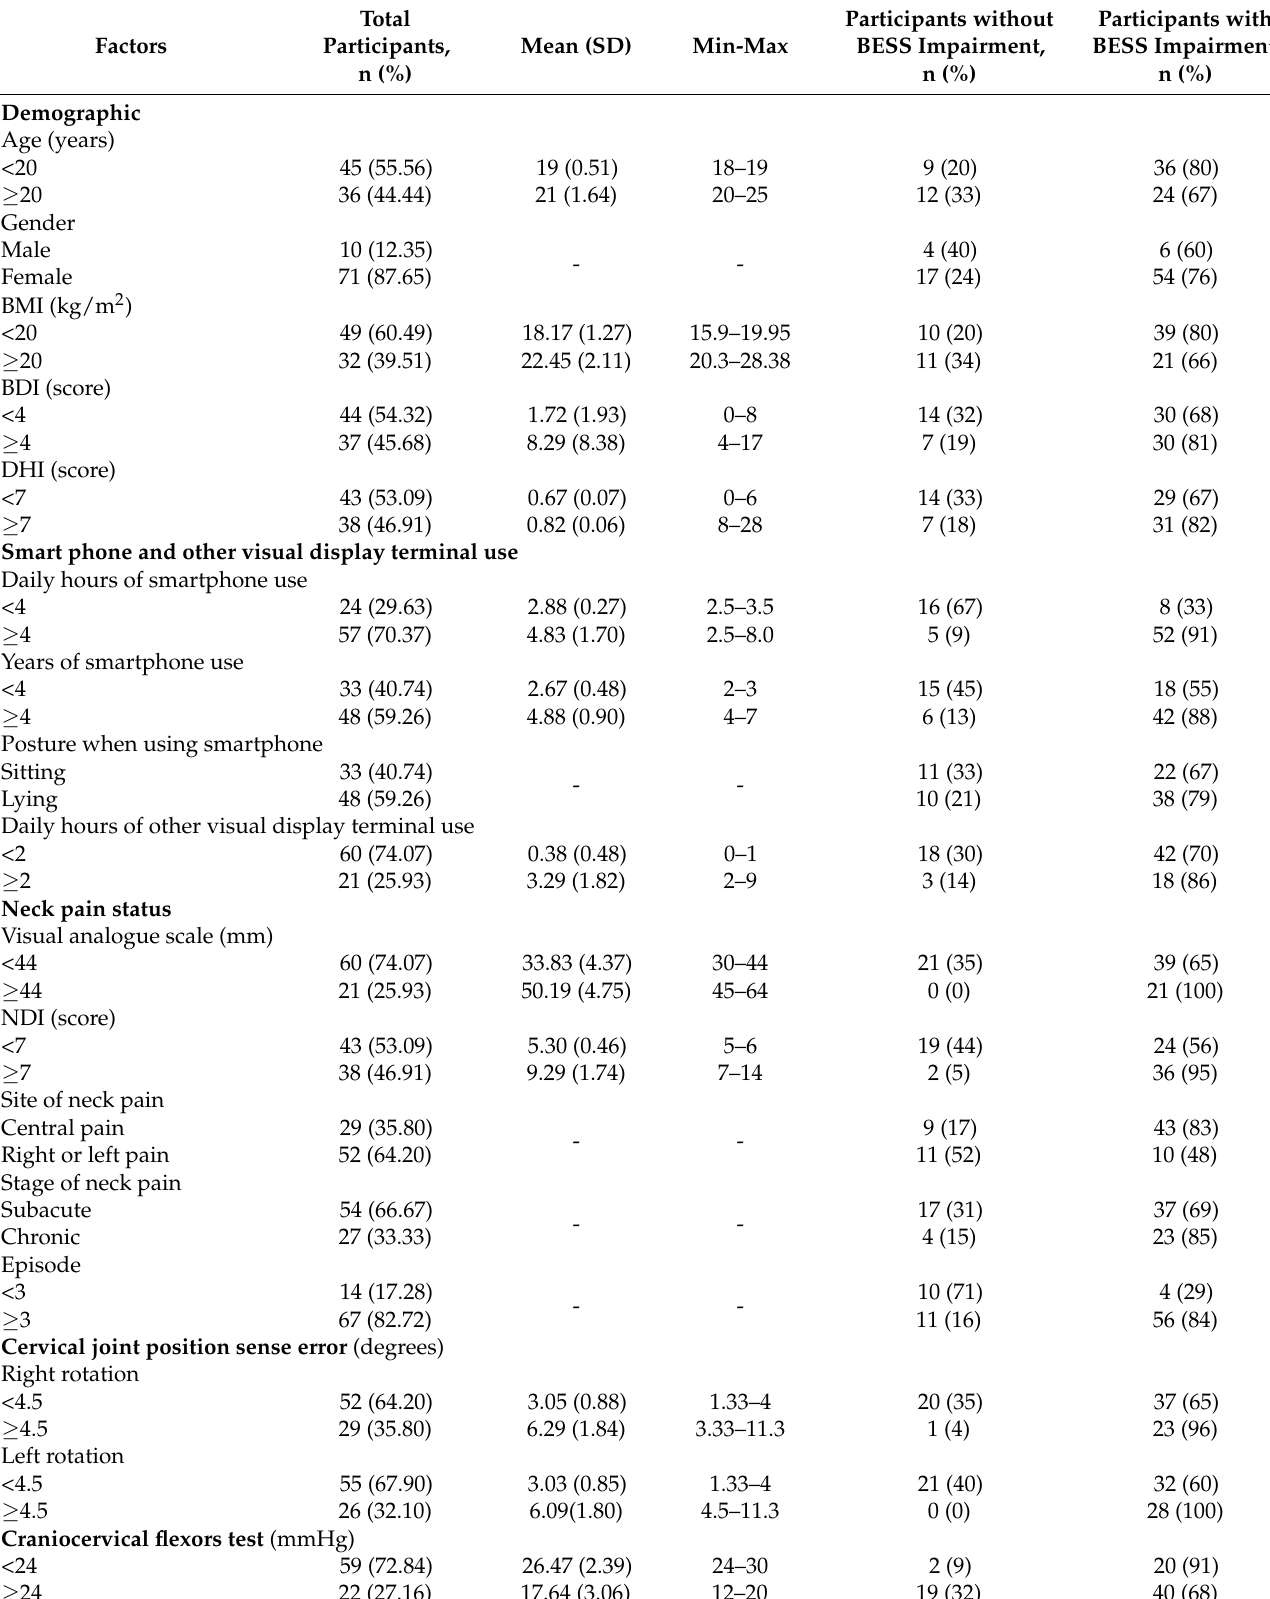
Table 1. Characteristics of participants (n =